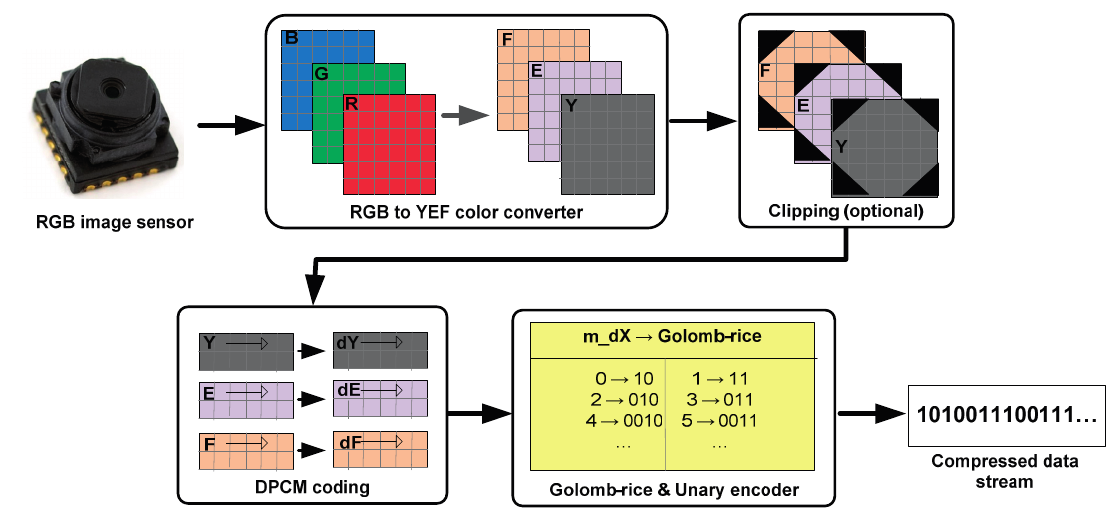
Figure 2. Block diagram of the proposed lossless compression